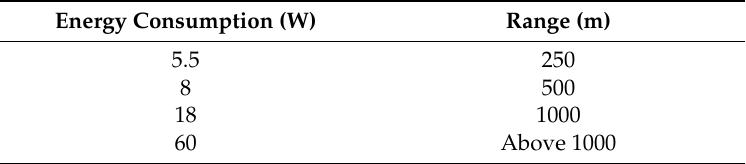
Table 2. Transmission Power VS Range (S2CR 48/47 Acoustic modem) [21]